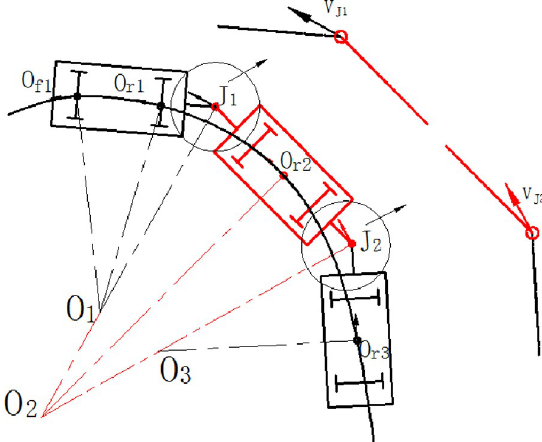
Fig 3. The kinematics model of the unmanned articulated